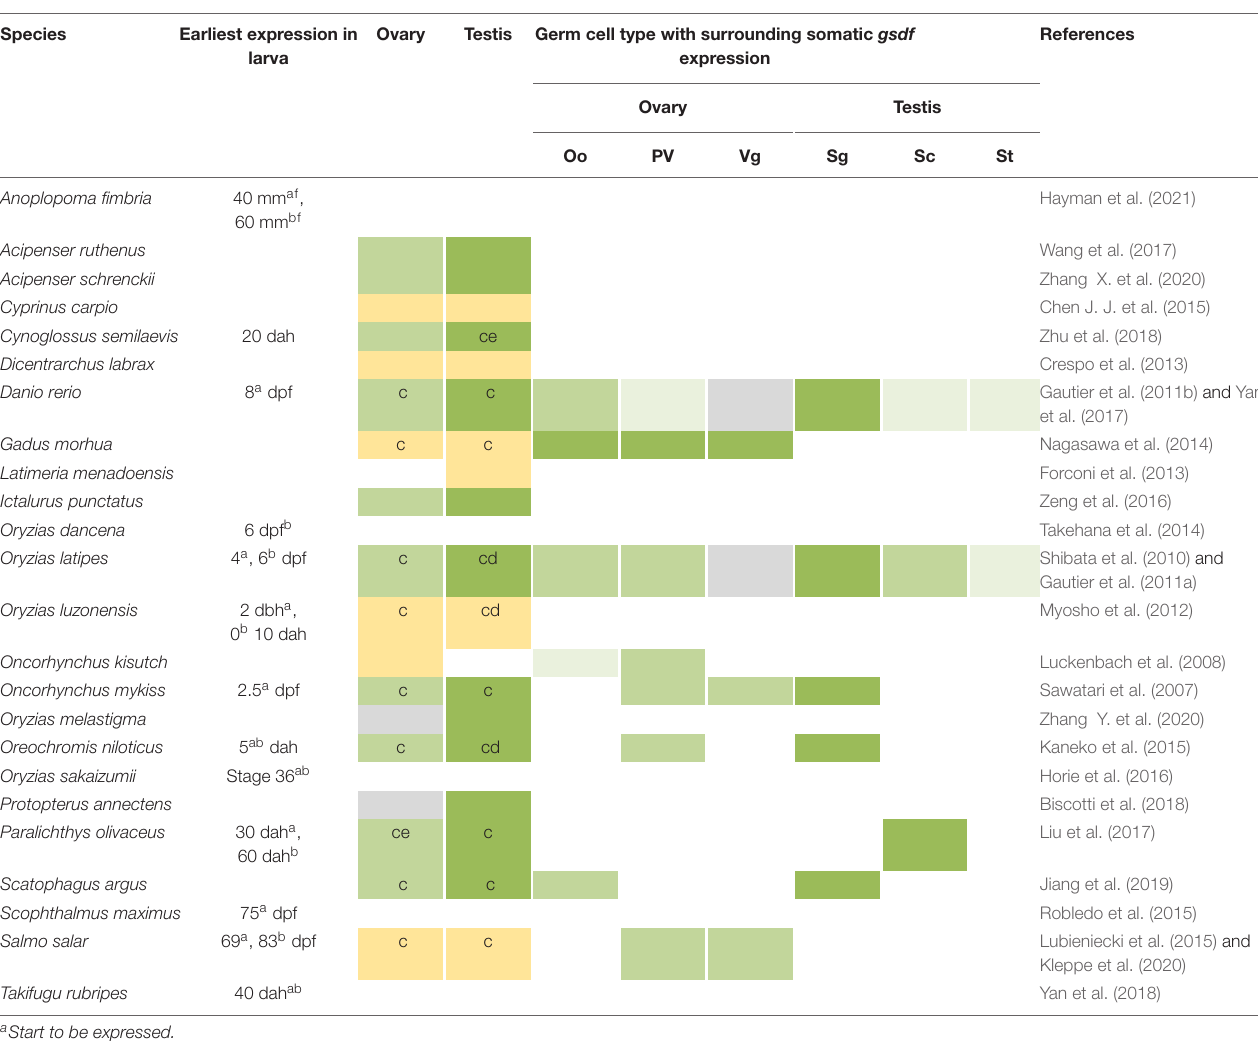
TABLE 1 | Expression of gsdf in gonochoristic